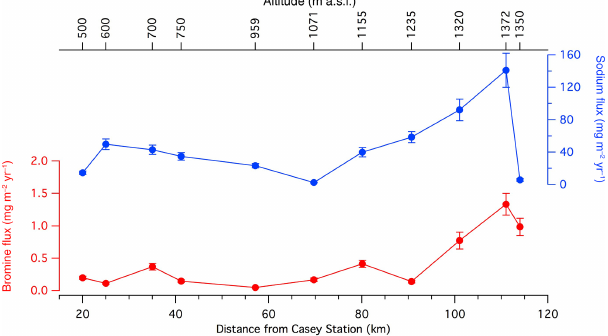
Figure 8. Fluxes of sodium and bromine along the 2016 Law Dome Traverse (indicated in Fig. 1). Uncertainties include uncertainties in the analysis (9% Br, 4% Na) and accumulation